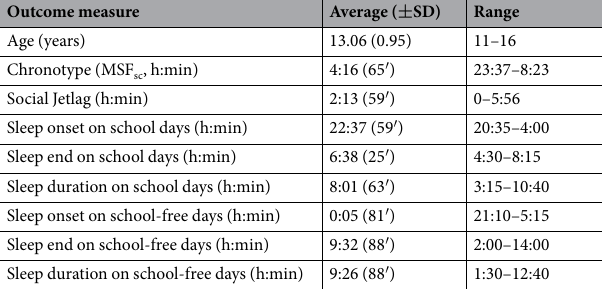
Table 1. Demographics of 219 female and 207 male high school students attending the first three school years (data from the Munich ChronoType Questionnaire). Data concerning chronotype, sleep onset and sleep end refer to external clock time and are reported in clock